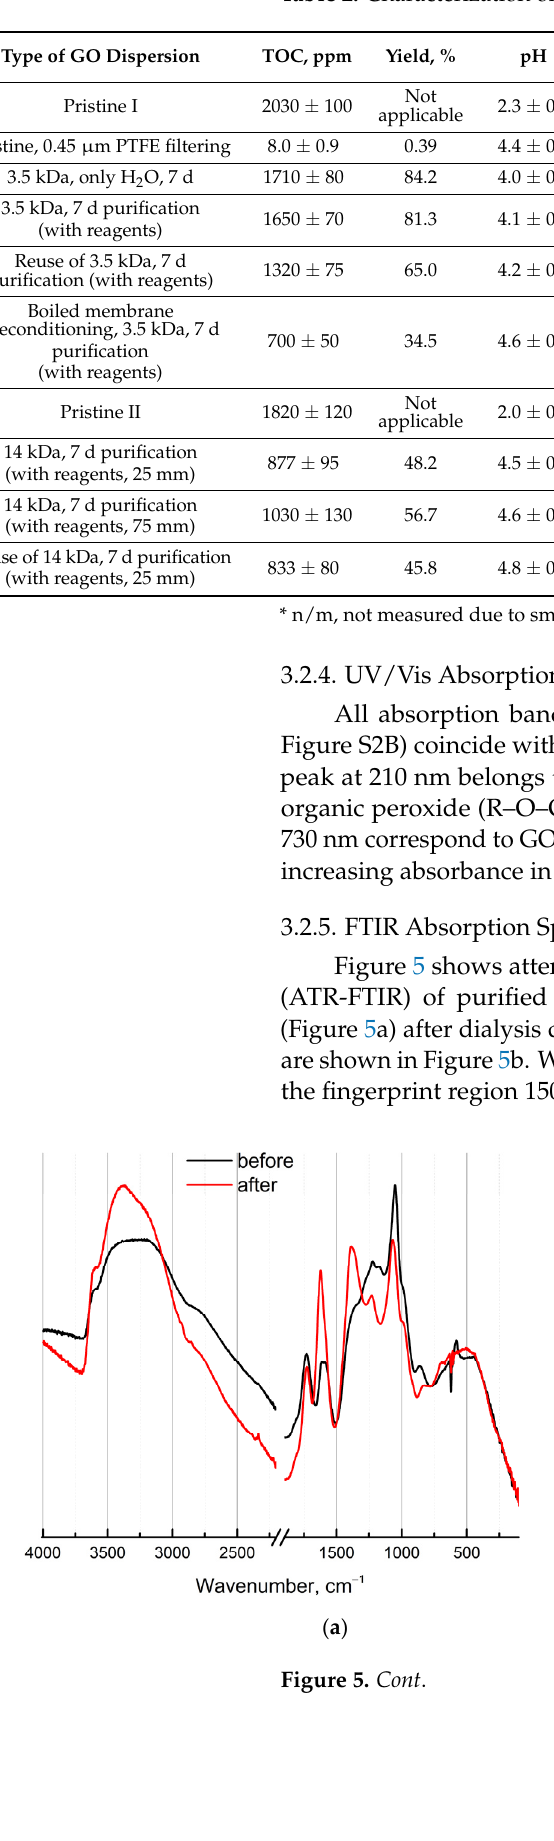
Table 2. Characterization of GO dispersions ( n = 3, p = 0.95).